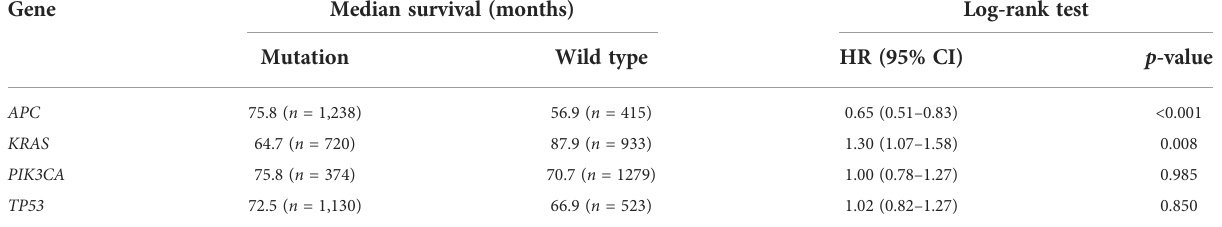
TABLE 2 Correlation between gene mutation and overall